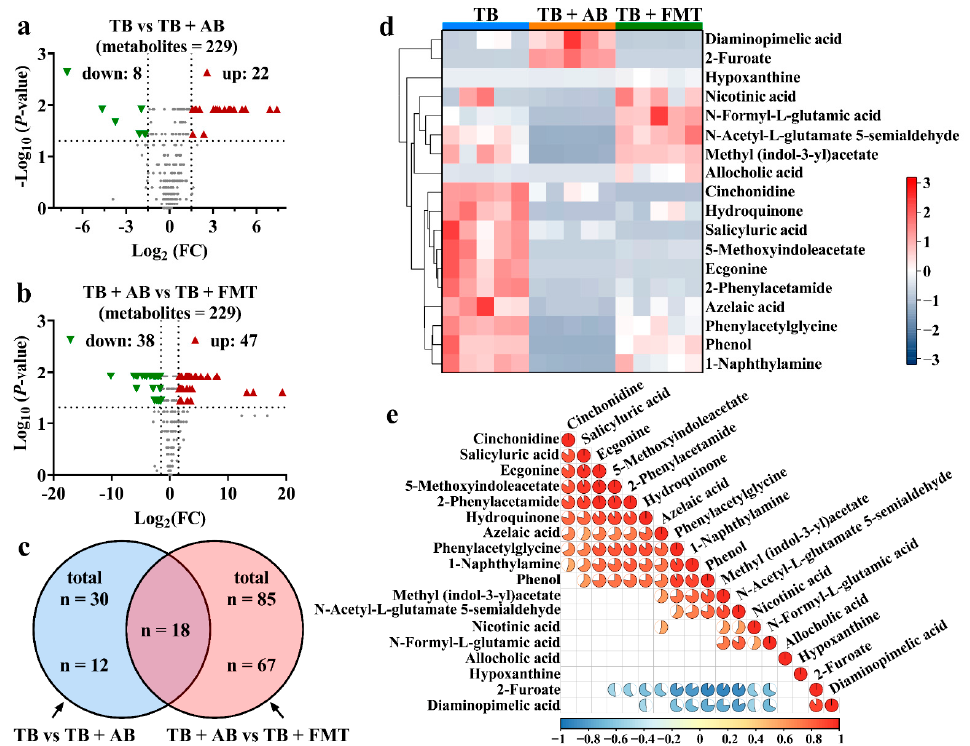
Figure 5. The overall changes in metabolic profiles and representative metabolites. ( a ) The changes in metabolites between the TB and TB + AB groups. ( b ) The changes in metabolites between the TB + AB and TB + FMT groups. ( c ) The cross-comparative analysis of metabolites among groups. ( d ) The heatmap of the 18 representative metabolites. ( e ) The correlation analysis among the 18 representative metabolites (the complete circle corresponds to a correlation coefficient ( r ) = 1 or − 1). Abbreviation: AB, antibiotics; FC, fold change; FMT, fecal microbiota transplant; TB, theabrownin. Table 1. The changes in metabolic pathways among